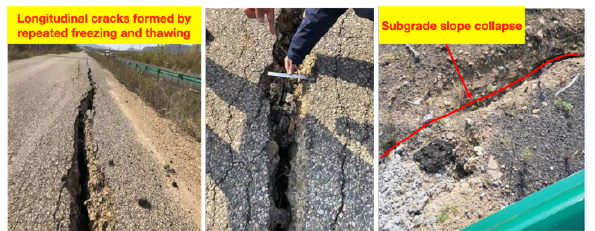
Figure 1. The frost heaving diseases of Shiwei-Labudalin